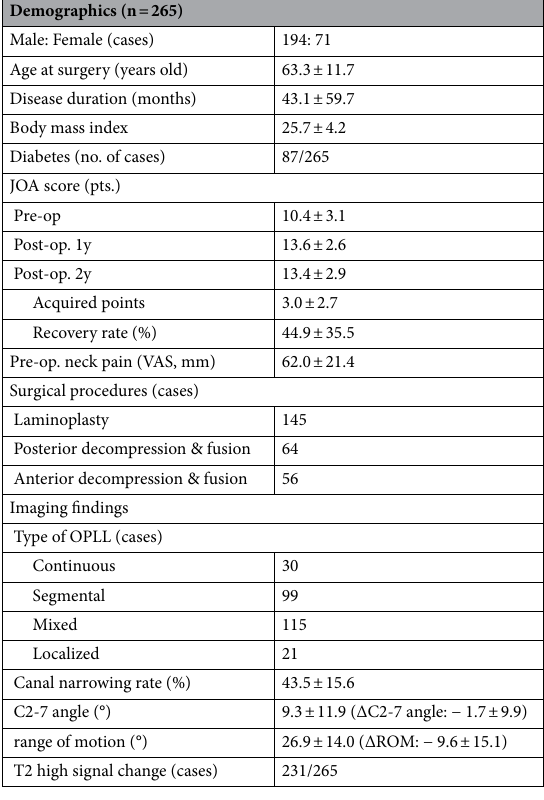
Table 1. Patient demographics.